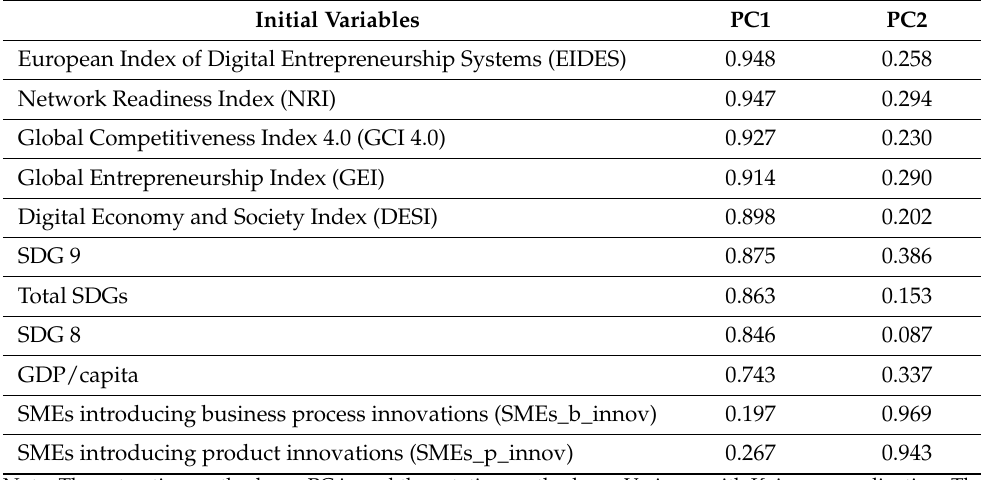
Table 5. Principal components for EU-25 countries (rotated component matrix).